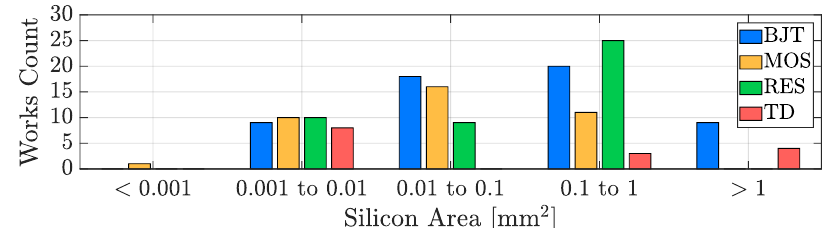
Figure 21. TDC silicon area distribution with sensing-type